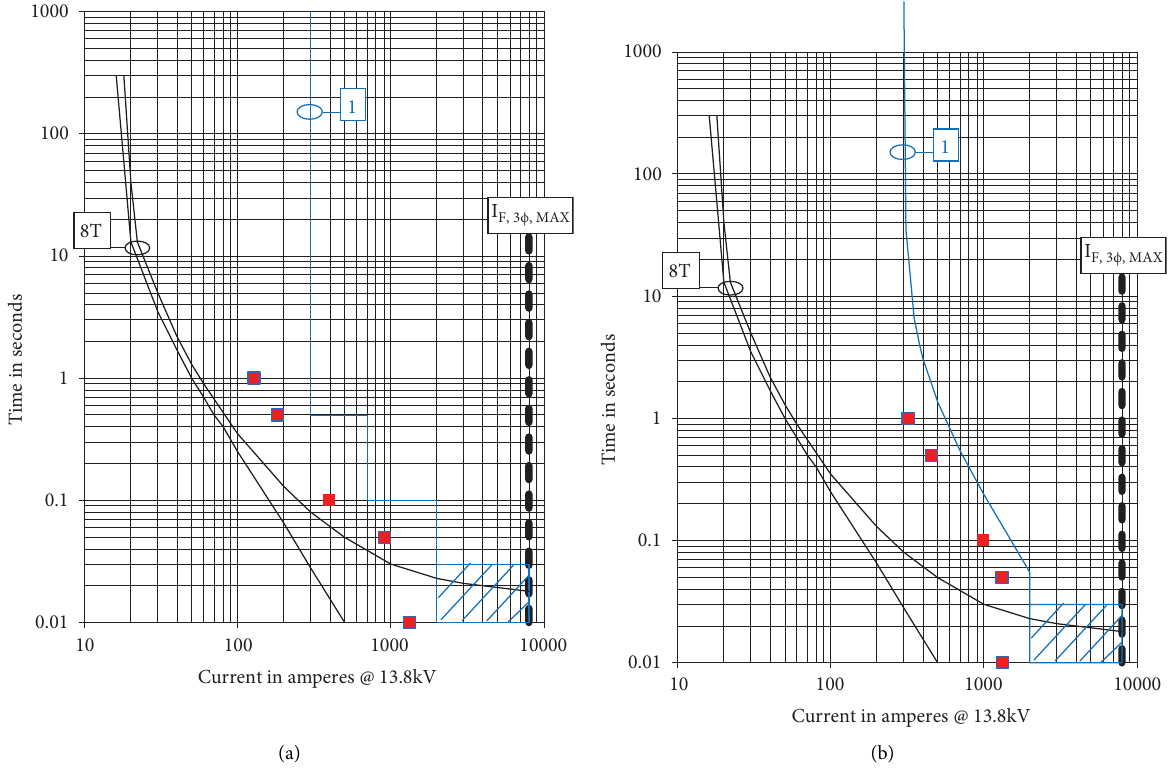
Figure 9: Example of solutions for d � 0.05km; (a) with defnite-time overcurrent functions (frst-stage pickup: 300A; frst-stage delay: 0.5s; second-stage pickup: 700A; second-stage delay: 0.1s); (b) with inverse-time overcurrent function (IEC extremely inverse curve; pickup: 300A; time multiplier: